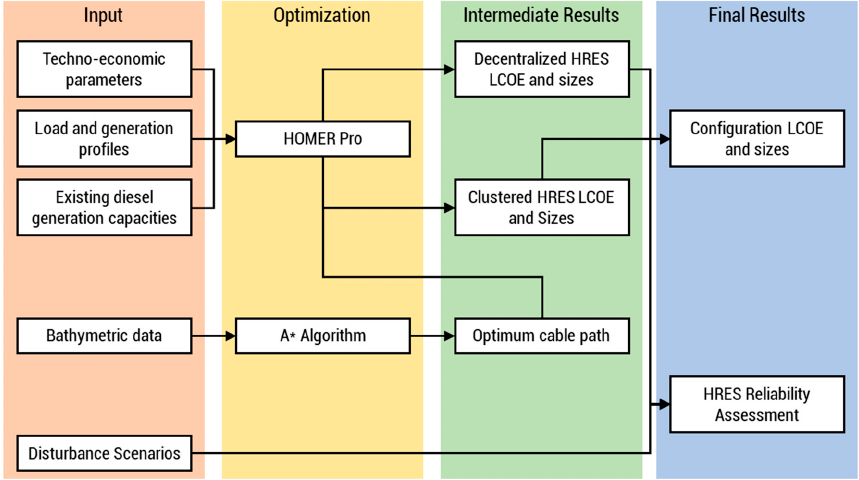
Figure 1. Flowchart of the general research approach.